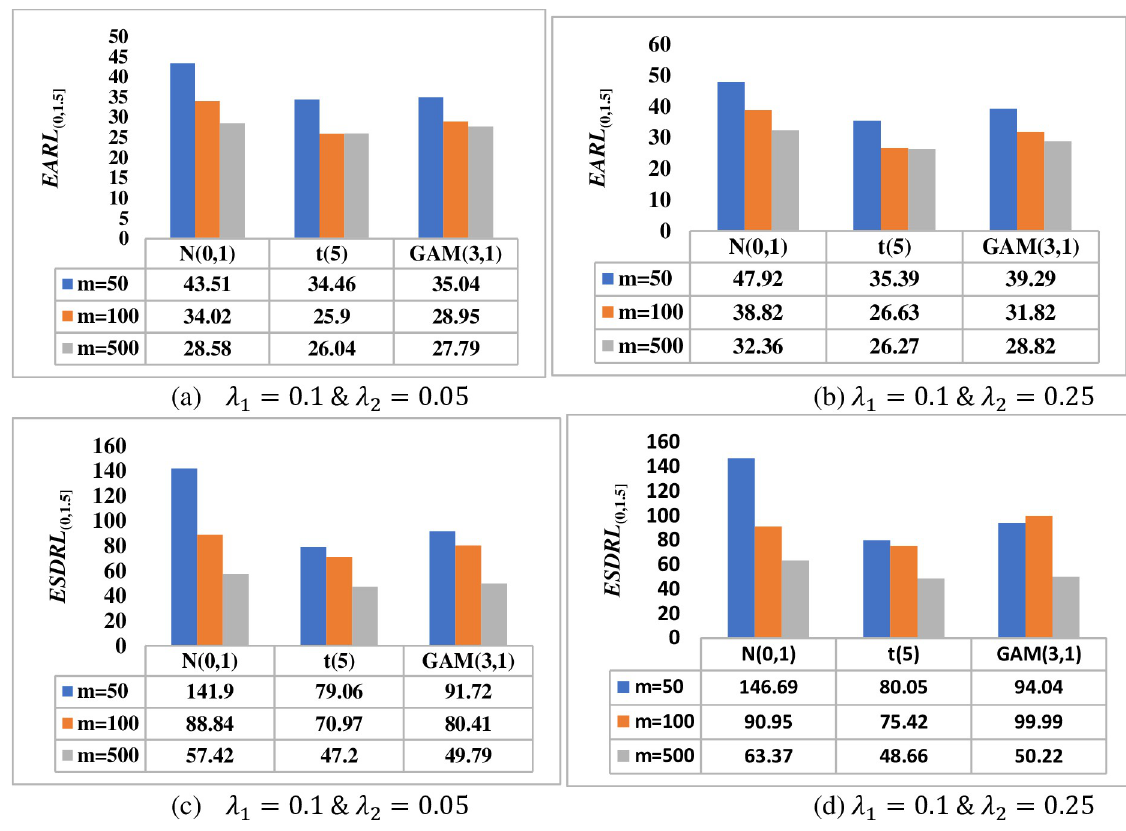
Fig 6. Effect of the phase I sample size on the performance of HHWMA W scheme when n = 5, λ 1 = 0.1, λ 2 2 {0.05, 0.25} and m 2 {50, 100,500} under N (0,1), t (5) and GAM (3,1) distributions.